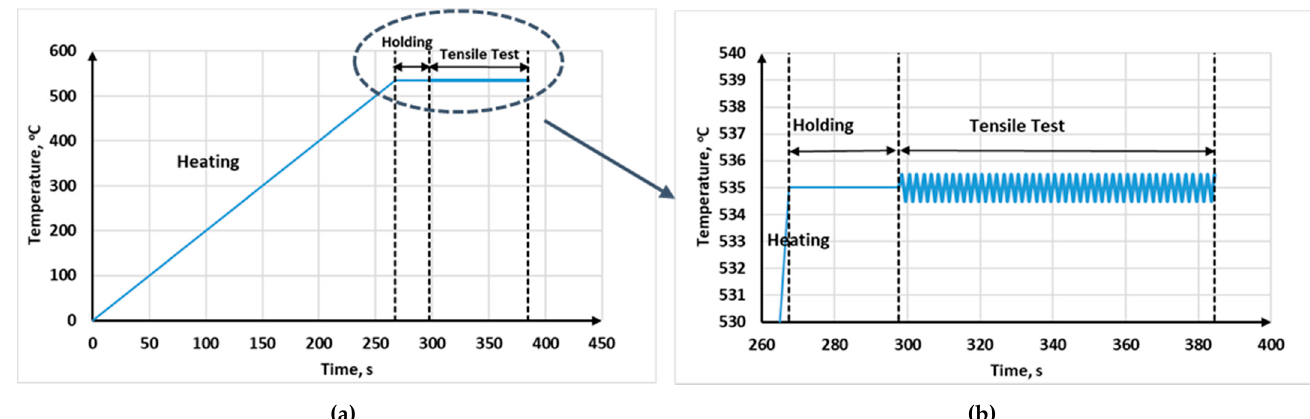
Figure 2. Temperature distribution along the longitudinal and transversal directions of a specimen: ( a ) measured tem- perature distribution along the longitudinal direction, ( b ) comparison of temperature difference (Tmax-Tmin) at ± 3 mm distance relative to the center along the longitudinal direction, and ( c ) measured temperature distribution along the transversal.